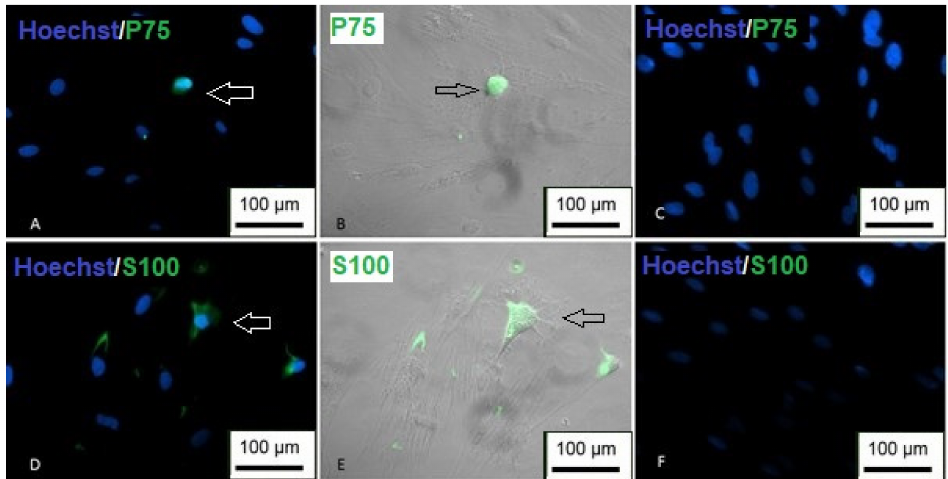
Figure 24. Immunocytochemistry of differentiation in Schwann cells. ( A , B ) Cells showing positive staining for P75 (green); ( C ) undifferentiated P75 control; ( D , E ) positive labeling for S100 (green); ( F ) undifferentiated S100 control (inverted optical microscopy—200 × ). Scale bar, 100 µ